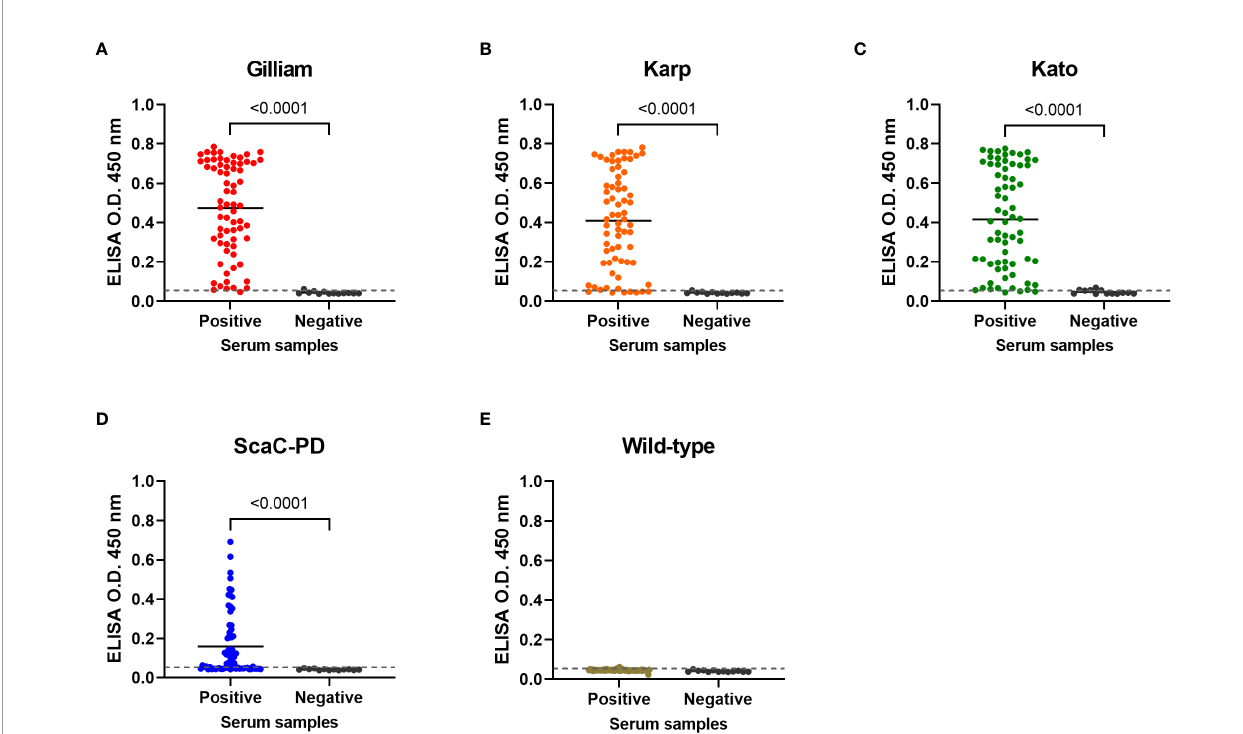
FIGURE 6 | Cell-based ELISA detection of ST in serum samples obtained from fi eld-caught or non-ST rats. Sixty-nine rat sera con fi rmed as having been infected with O. tsutsugamushi by IFA (Positive) and thirteen negative control rat sera (Negative) were subjected to cell-based ELISA using cells displaying Gilliam TSA56 (A) , Karp TSA56 (B) , Kato TSA56 (C) , and ScaC-PD (D) antigens, and cells infected with wild-type baculovirus (E) . Individual data points are shown and the solid line represents the mean value. Dotted line: cutoff value of 0.056 determined as the mean value of negative rat serum reactivities against each of the antigens plus two standard deviations. P -values determined by Welch ’ s t -test are displayed above the